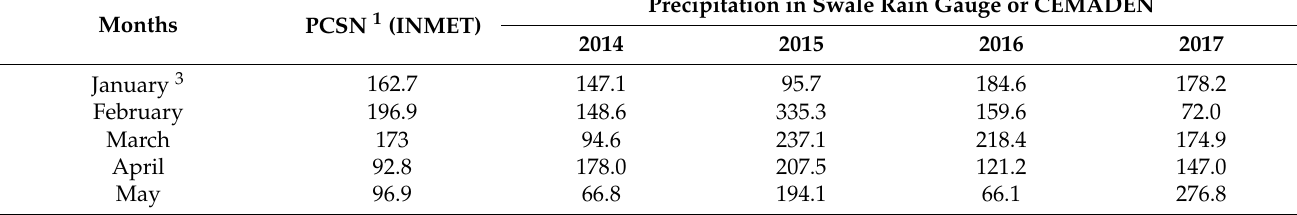
Table 2. Rainfall in monitoring years in contrast to the precipitation climatological standard normal (INMET) of Florian ó